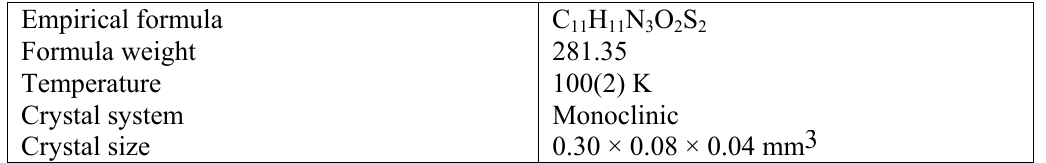
Table 2. Crystallographic data for compound 5a